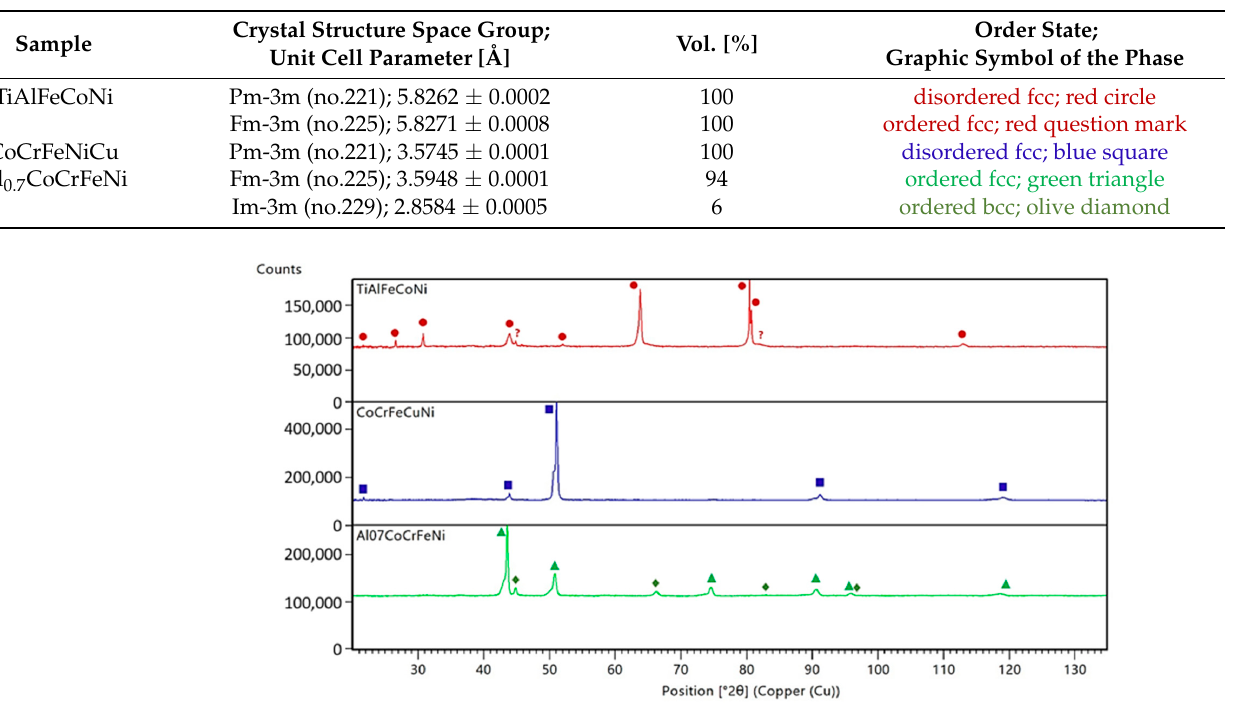
Table 6. Results of the phase analysis performed using ICSD database, taking into account only the relevant cubic space groups, unit cell parameters, and percentage of phase volume contribution Vol.% obtained from XRD data.